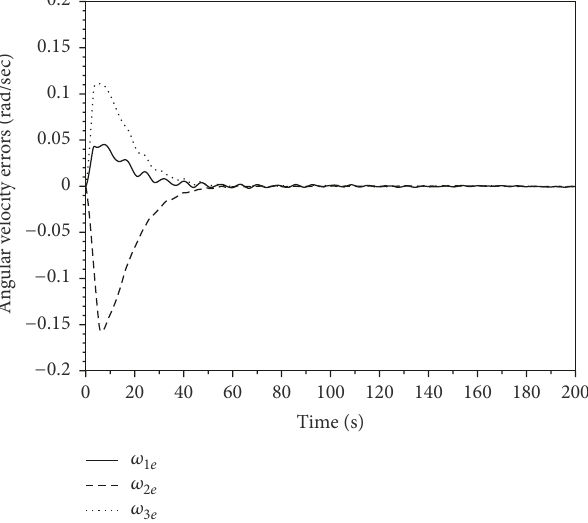
Figure 3: Angular velocity errors under PD-SMC.